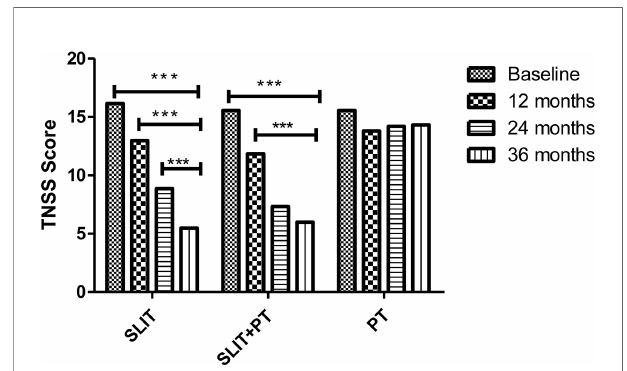
FIGURE 1 | Total Nasal Symptoms Score (TNSS) of 3 treatment groups at different stages. *** denotes level of statistical signi fi cance.